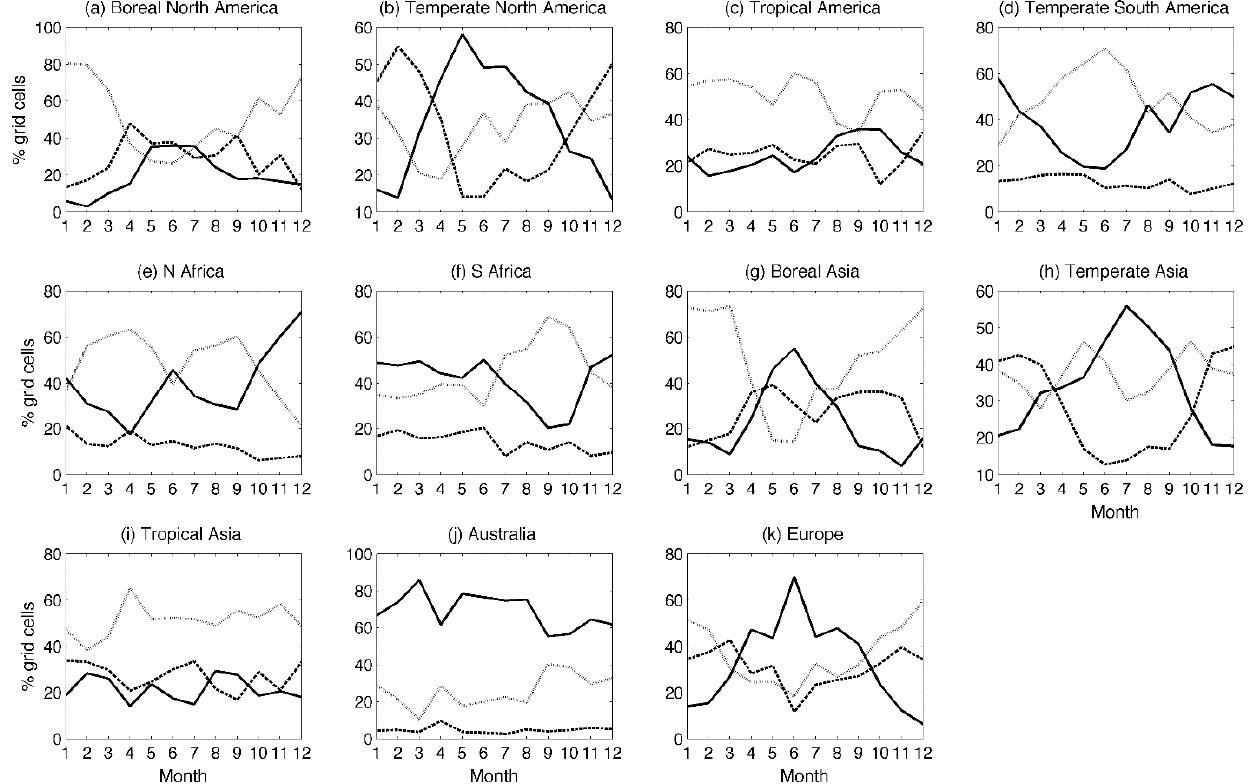
Figure 11. Percentage of vegetated grid cells in each Transcom region ( a – k ) with significant correlations ( p < 0.05) between NDVI anomalies and anomalies in climate (cumulative precipitation of lead 1–6 and temperature at lead 0 corrected for snow interference, both positively correlated with NDVI, black solid line) and in current monthly precipitation, snow, aerosols and clouds (negatively correlated with NDVI with p < 0.05, excluding grid cells with significant positive NDVI–climate correlations, black dashed line), and percent remaining vegetated grid cells showing no correlations with the variables tested (unknown, gray dotted line). They sum up to 1 for each month in each